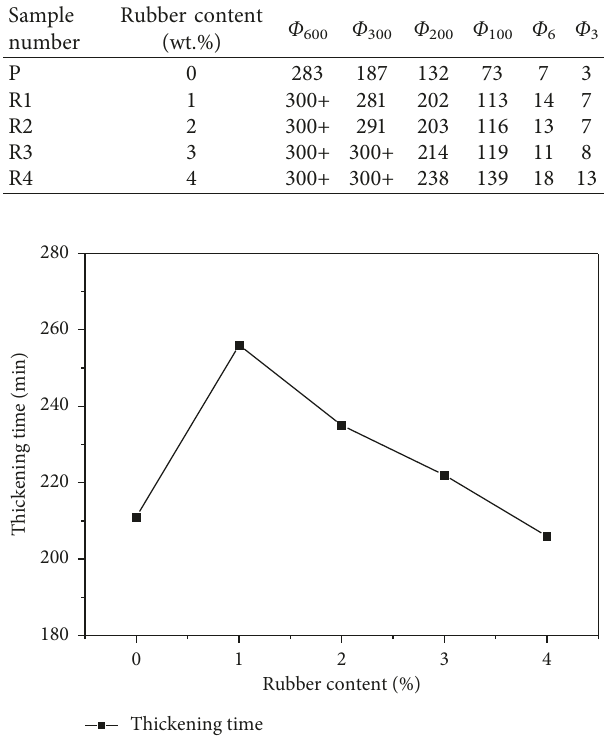
Figure 4: Dependence of rubber content on thickening time of cement